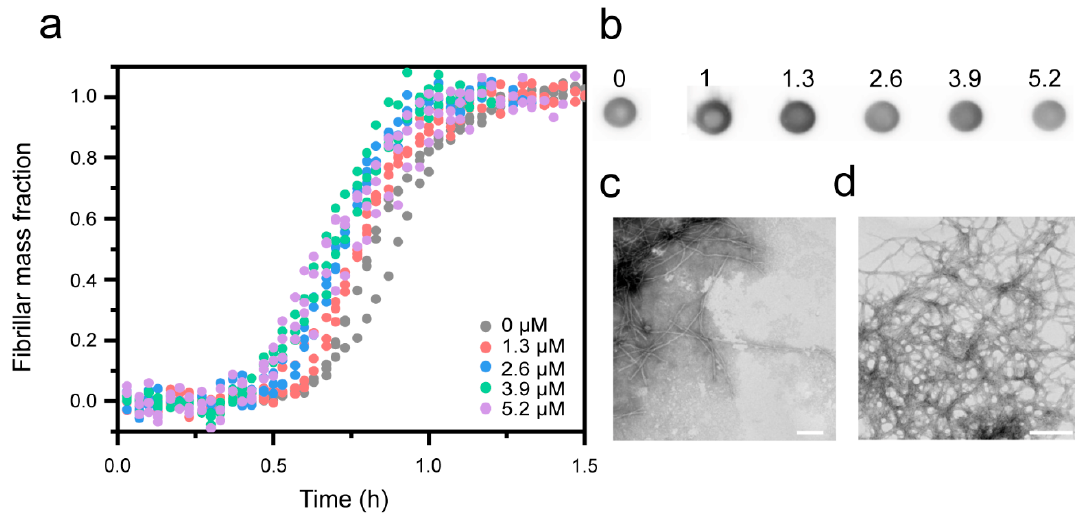
Figure 6. A β (1-42) amyloid formation in the presence of Cu + at pH 8.0. ( a ) Normalized kinetic profiles of 2.6 µ M A β (1-42), measured by ThT (5 µ M) fluorescence, in the presence of indicated concentrations of CuCl 2 and 5x molar excess 1,4-dithiothreitol (DTT) to generate Cu + . The non-normalized dataset is shown in Figure S2b. ( b ) Dot blot showing LOC-positive A β (1-42) species at the endpoint of the kinetic experiments shown in ( a ). The full, uncropped image of the dot-blot membrane is shown in Figure S4. ( c , d ) TEM images of 2.6 µ M A β (1-42) amyloid fibrils formed in the presence of ( c ) 1.3 µ M and ( d ) 5.2 µ M Cu 2 + . The scale bars represent 200 nm.